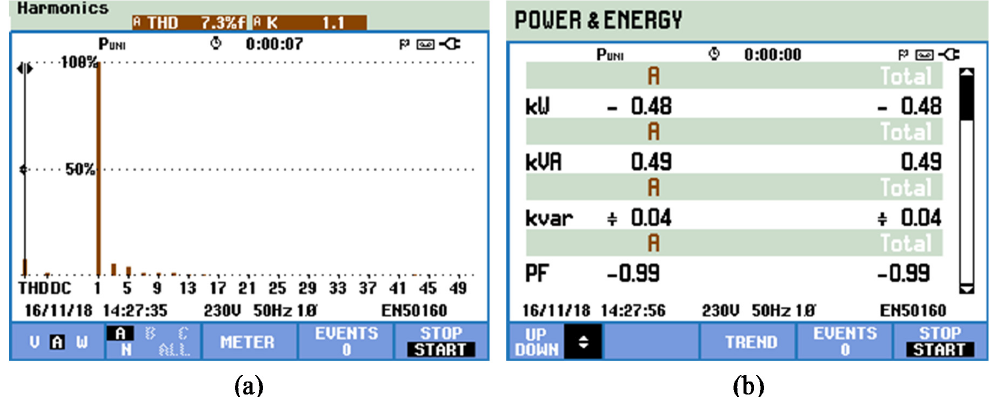
Figure 20. Experimental results during the MF-EVCS operation in R2G mode combined with R2V mode: ac-side voltage ( v g : 50 V/div); Total home current ( i g : 5 A/div). Energies 2020 , 13 , 1864